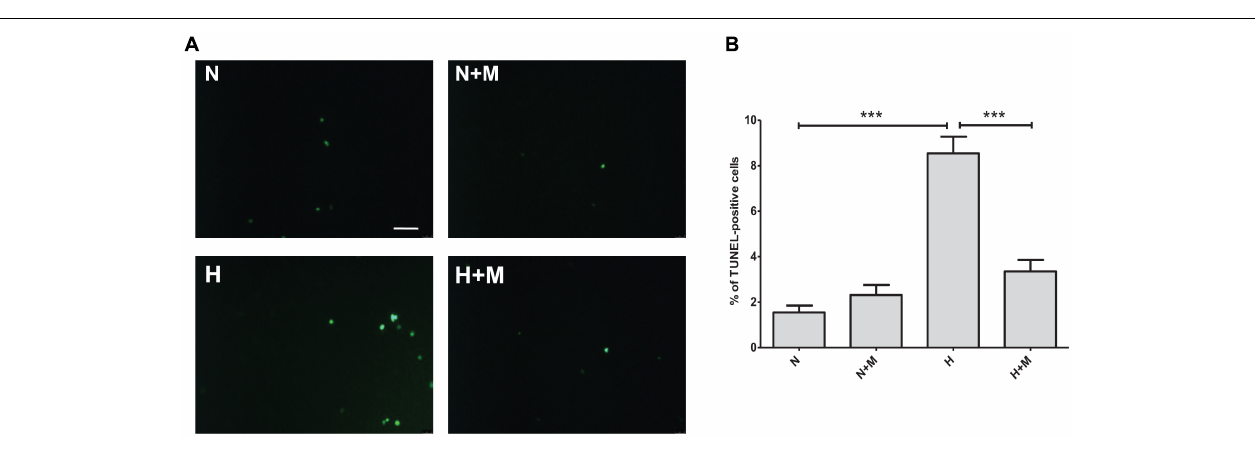
Frontiers in Pharmacology |